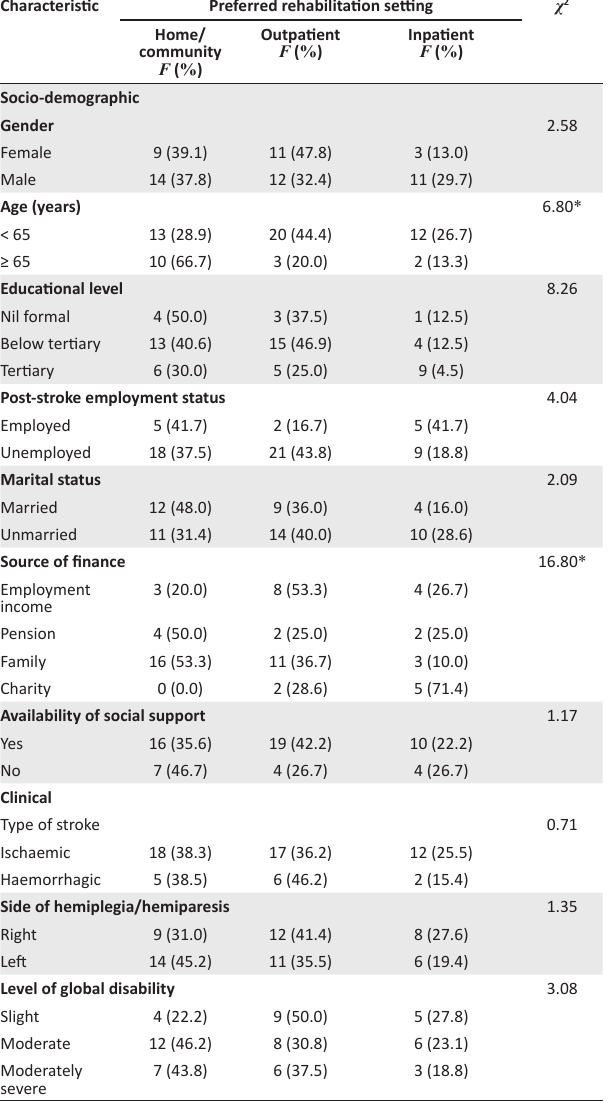
TABLE 2: Personal factors associated with preferred rehabilitation setting. Characteristic Preferred rehabilitation